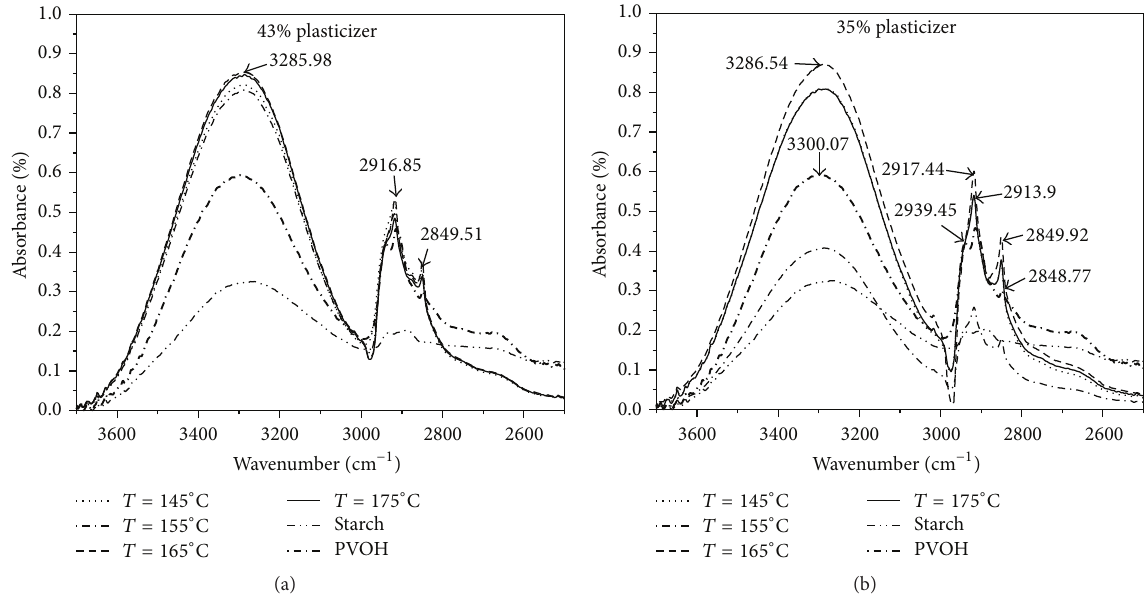
Figure 5: The dependence of ATR absorption in the absorption range of 3700 cm −1 to 2500 cm −1 on the plasticizing level ((a) 43%; (b) 35%) and the extrusion temperature (10kg load).